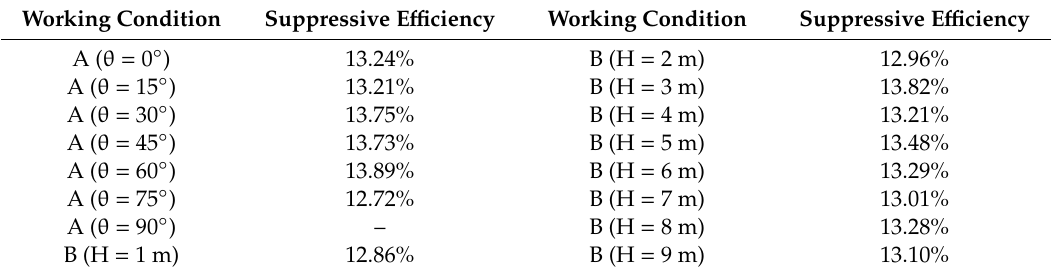
Table 4. The suppressive efficiency of a series of buoys to surges under working conditions A and B. Working Condition Suppressive E ffi ciency